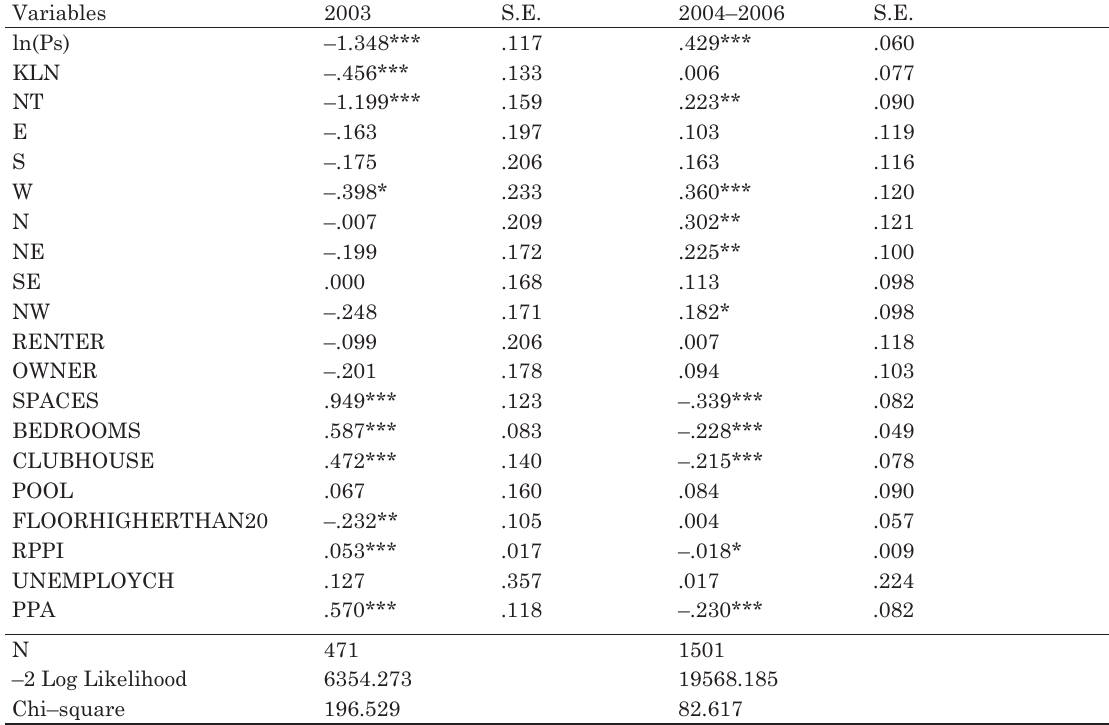
Table 5c. The Cox model results (occupied